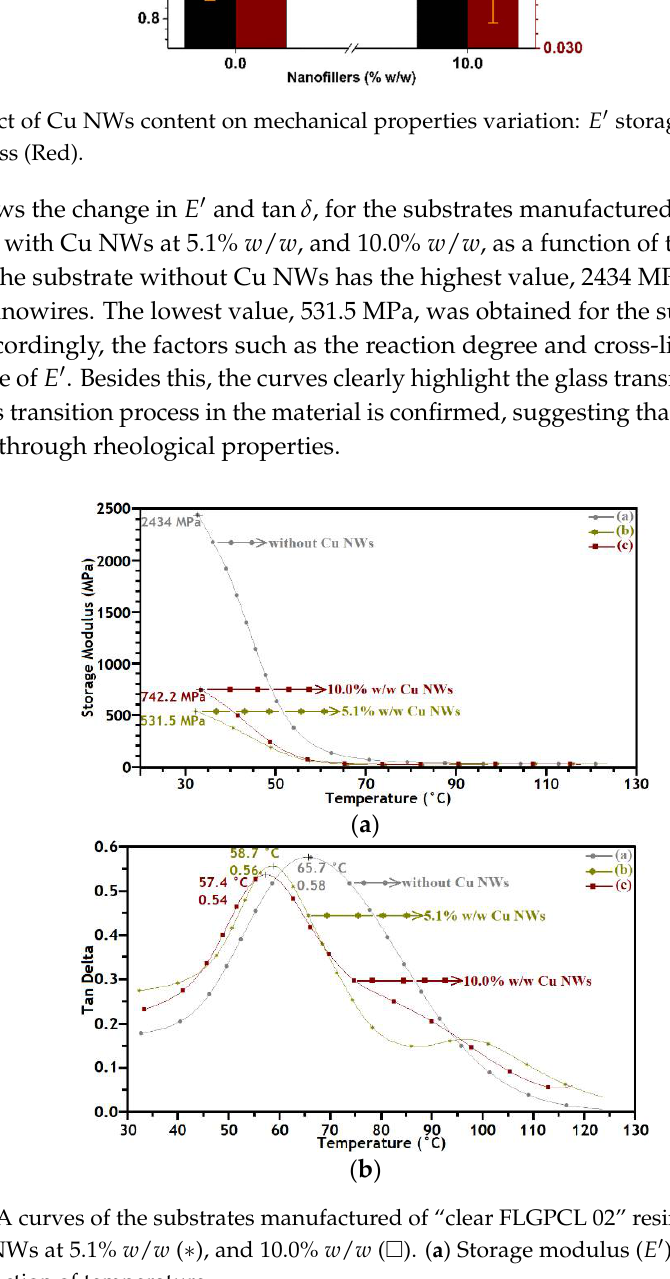
Figure 8. Effect of Cu NWs content on mechanical properties variation: E (cid:48) storage modulus (Black) and H hardness (Red).